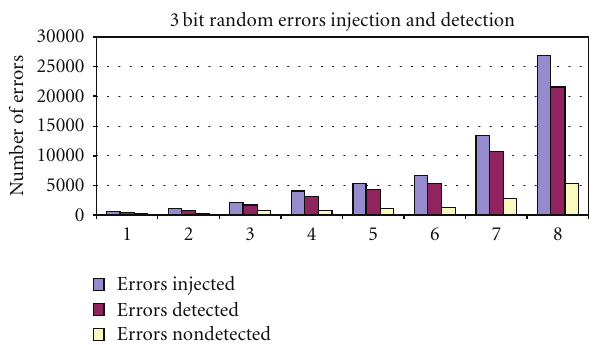
Figure 23: Results for 3 bit error injection.